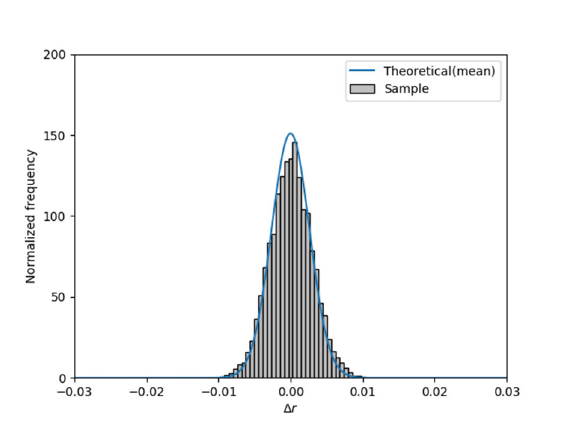
Fig. 11 . Relationship between changes in the mean of ABIC and sample variance 𝑢 with changes in the hyperparameters (when 𝐕(cid:3553) 𝐦 (cid:3404) 𝑝 (cid:2870) (cid:3554)𝐕 𝐦 )